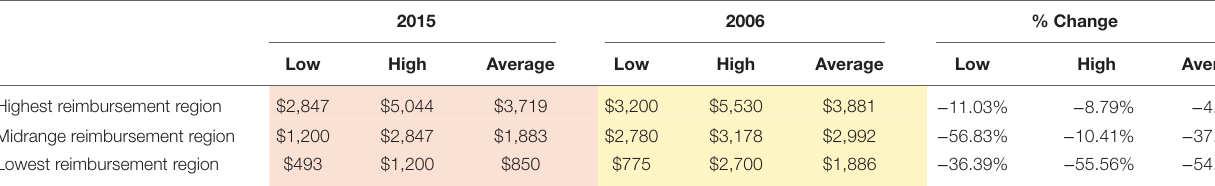
Table 5 | Medicaid orthodontic reimbursement rate change from 2006 to 2015 by region.